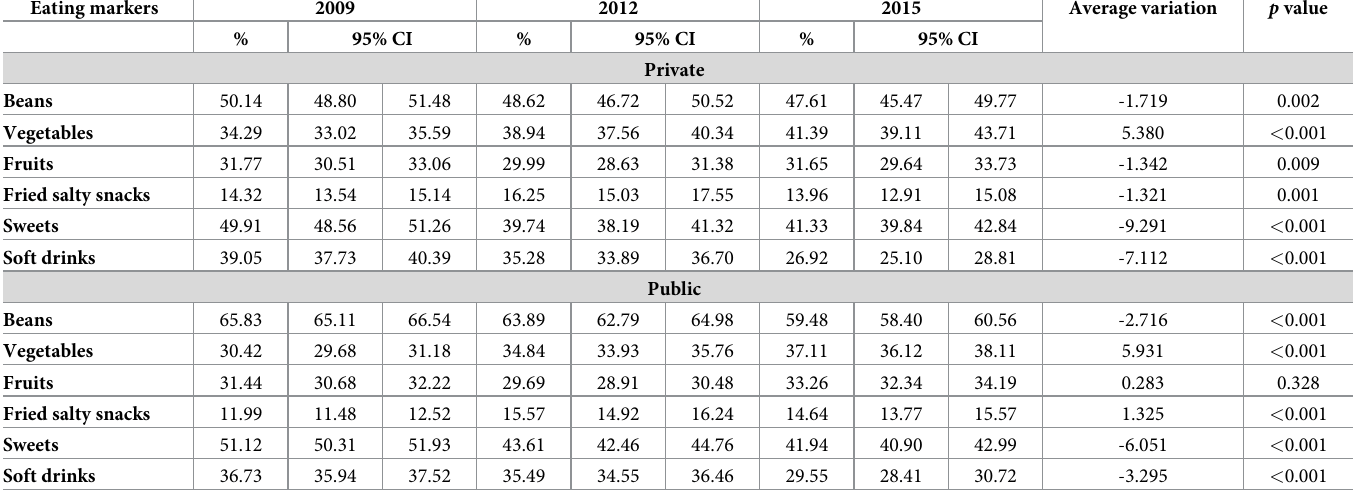
Table 5. Trends in prevalence of regular food consumption ( � 5 times/ week) of eating markers, according to school administrative status, from 2009 to 2015. Bra- zil, 2009, 2012 and 2015. Eating